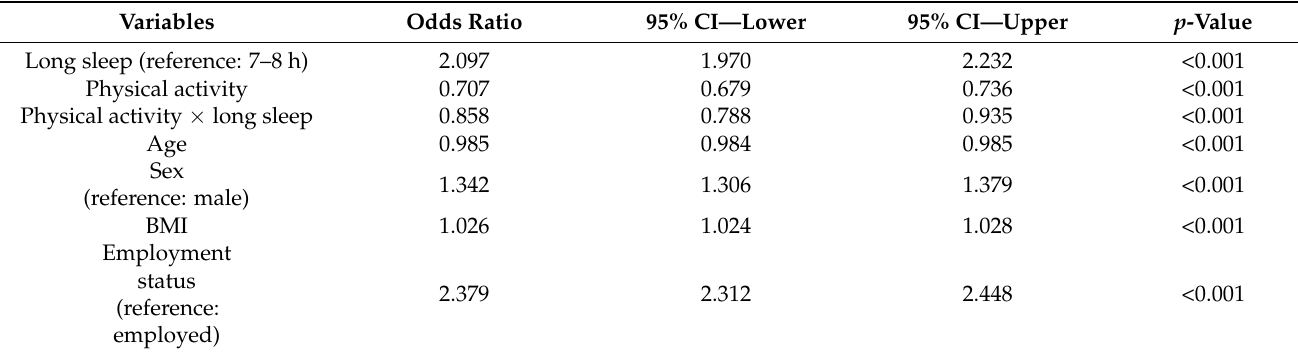
Table 11. The moderating effect of physical activity on the relationship between long sleep compared to healthy sleep and emotional distress predictions among Whites ( n = 227,823).